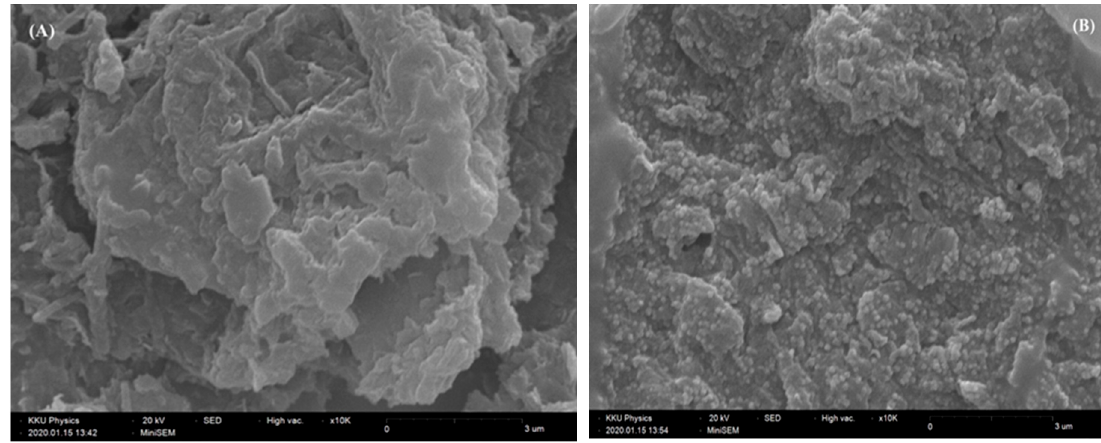
Figure 1. ( A ) Scanning electron microscopy (SEM) image of graphene oxide (GO) and ( B ) AuNPs deposited on GO.